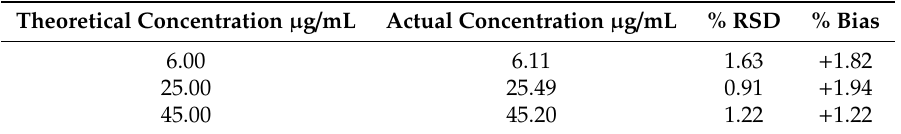
Table 6. Accuracy results for blinded CLA samples ( n = 5).